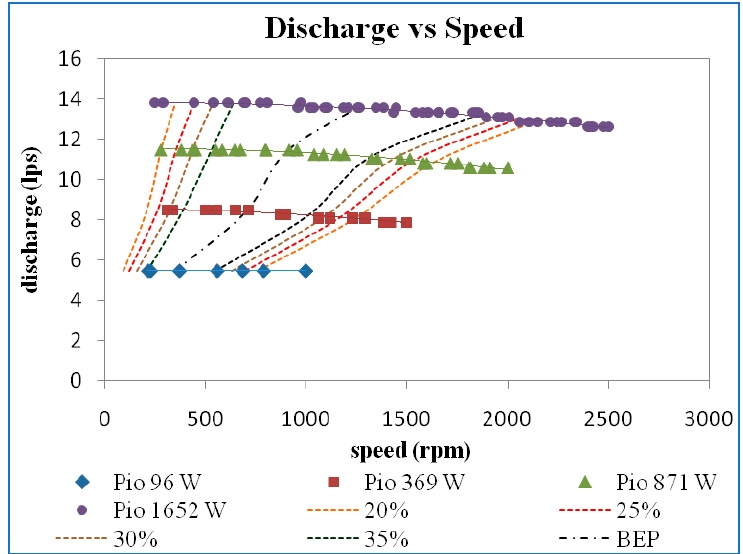
Figure 23. Discharge vs. speed and iso-efficiency line at 19 GVO.